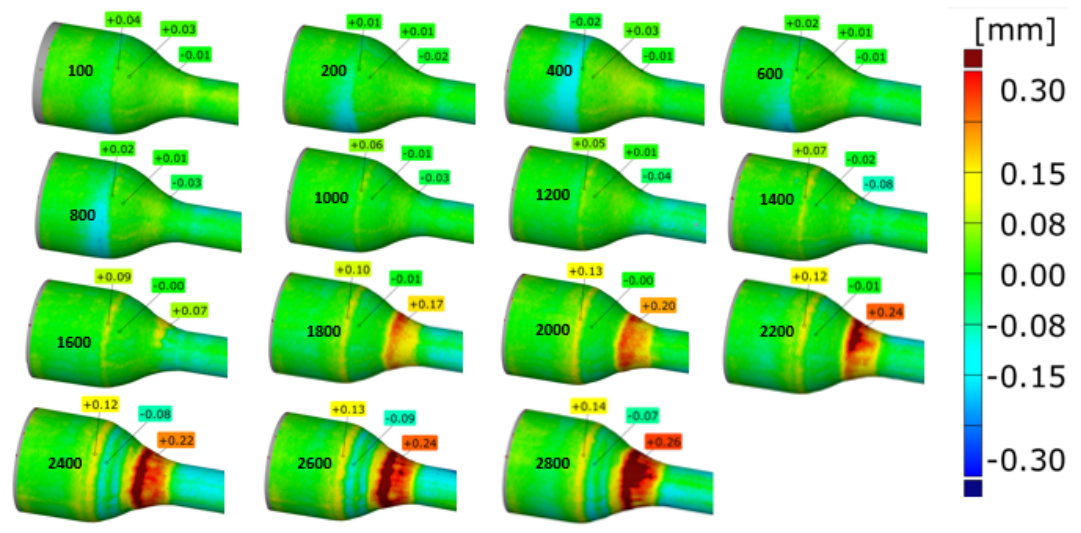
Figure 17. Comparison of the scans of forgings in the form of a change in the shape of the selected area in respect of the 100th forging, from 500 to 2800 items.